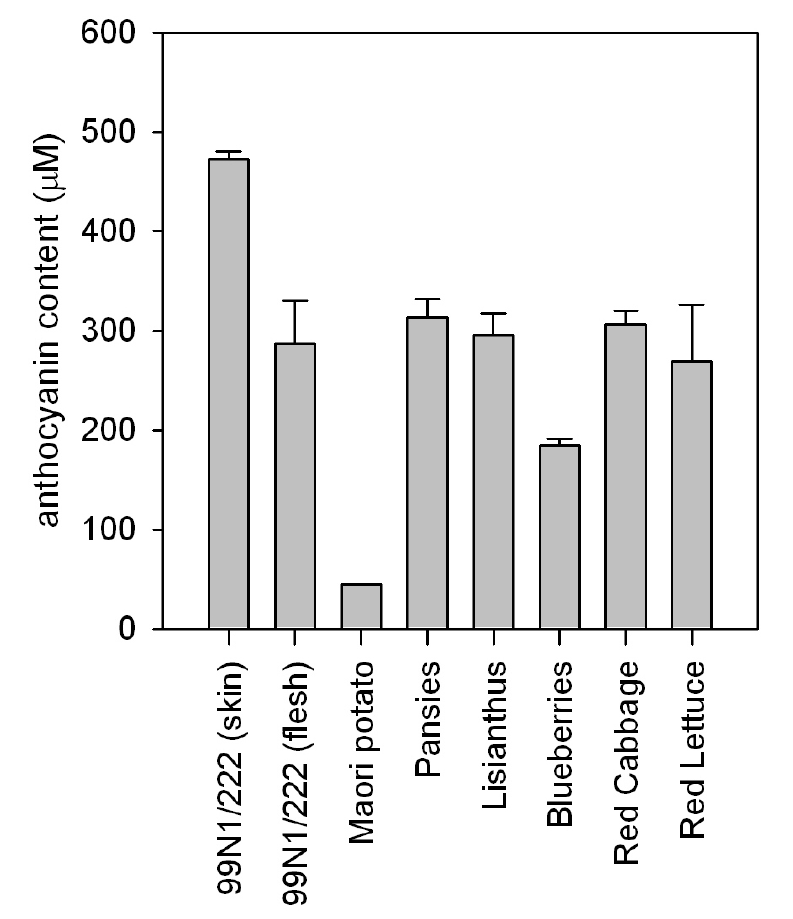
Figure 2 . Anthocyanin content of the indicated sources. Anthocyanins from 1 g of fresh material was extracted into 10 mL of acidified methanol. Vertical lines represent the